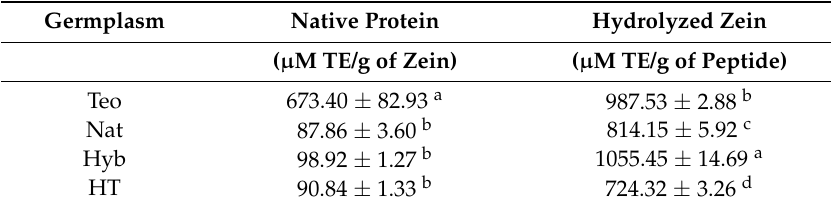
Table 2. Antioxidant capacity evaluation of native and hydrolyzed zein.